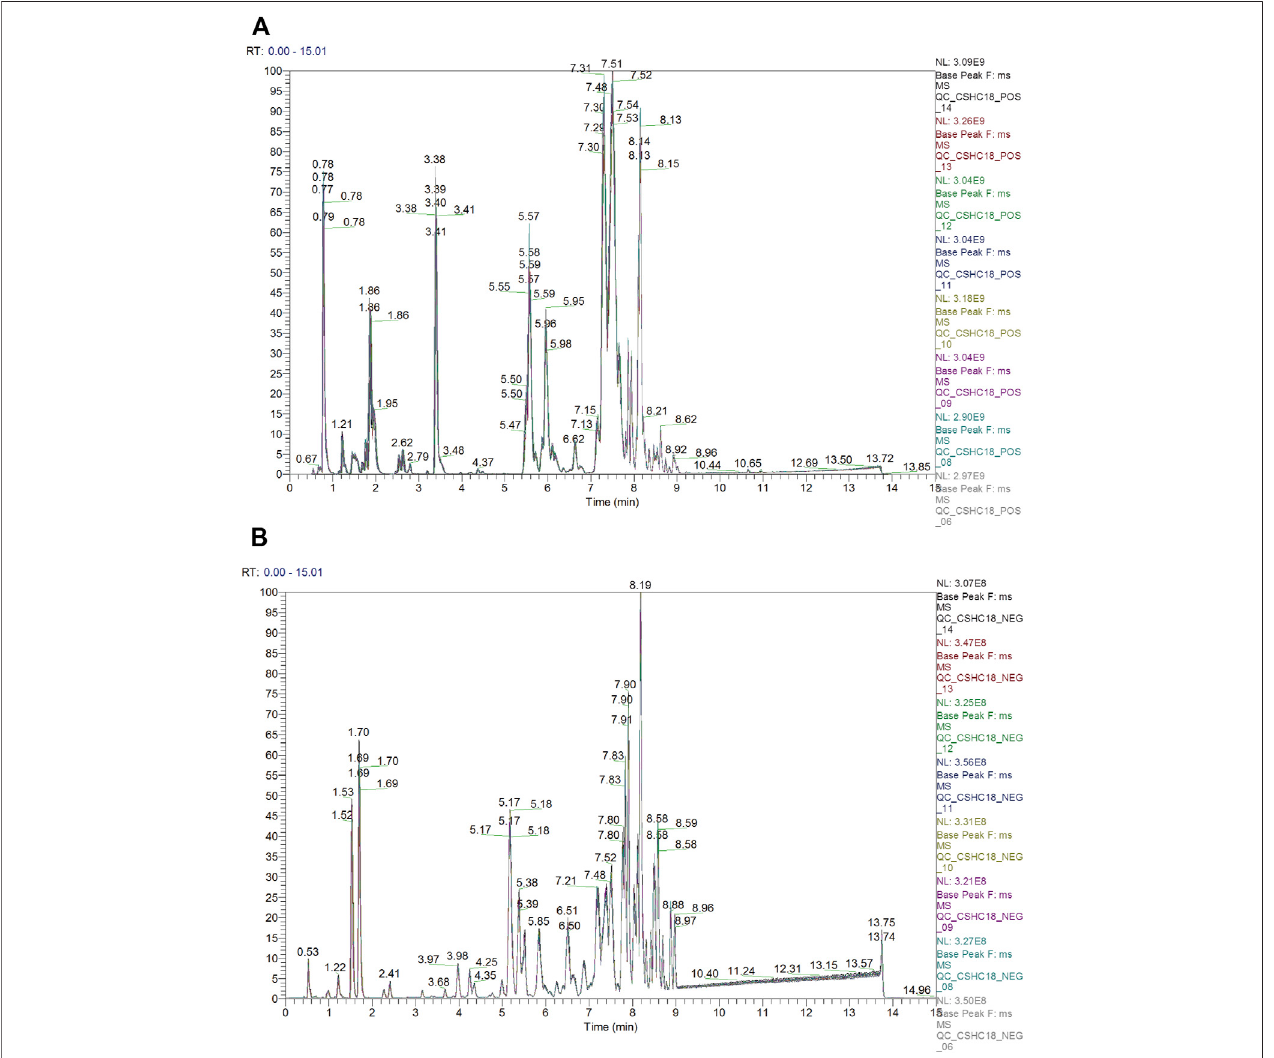
FIGURE 3 | Quality control and lipid identi fi cation of lipidomic data from prefrontal cortex tissues of ApoE − / − mice fed continuous high-fat diets combined with boundstimulation. (A,B) BPC(basepeakchromatogram)overlaysmapsofQCsamplesfromprefrontalcortextissue(left:positiveionpattern;right:negativeionpattern). (C) CV distribution of lipid metabolites in QC samples from prefrontal cortex tissue. [RSD_30_number (RSD (CV) ≤ 30%): the number of lipid metabolites in QC sample with RSD (CV) less than or equal to 30%; RSD_Ratio: the ratio of the number of lipid metabolites with RSD (CV) less than or equal to 30% to the number of all detected lipid metabolites in QC sample; Ratio ≥ 0.6 means the data Ratio ≥ 0.6 issatisfactory] (D) Statistical plots of lipid subclasses and the number of corresponding lipid metabolites in prefrontal cortex tissue. The vertical axis shows the lipid subclasses identi fi ed in this experiment, the horizontal axis shows the number of lipid metabolites identi fi ed in each lipid subclass, different colors indicates different lipid categories.